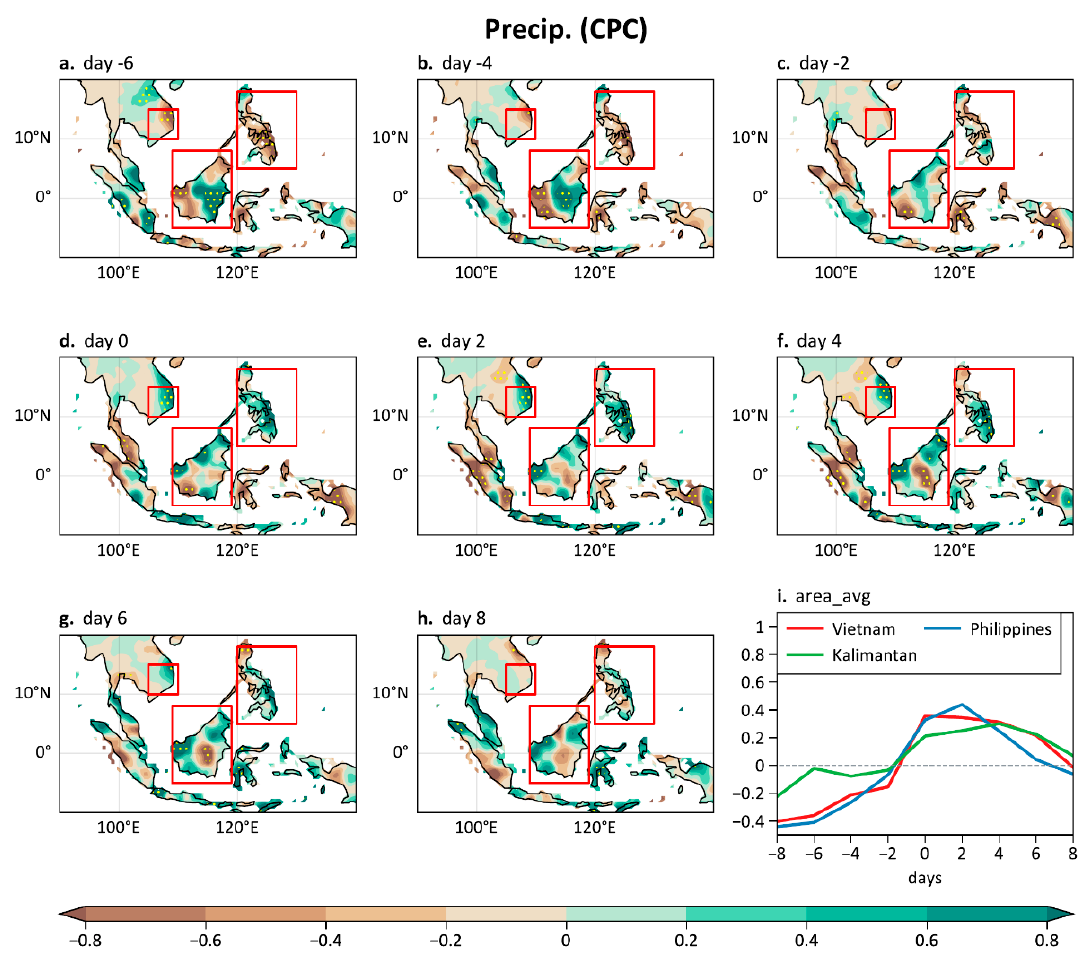
Figure 7. ( a – h ) Composite anomalies of CPC precipitation over land (mm day − 1 ) at days − 6 to 8 with an interval of 2 days during the strong EAWM events. ( i ) Composite of area-mean landmass precipi- tation anomalies for Vietnam (10 ◦ –15 ◦ N, 105 ◦ –110 ◦ E), Kalimantan Island (5 ◦ S–8 ◦ N, 109 ◦ –119 ◦ E), and the Philippines (5 ◦ –18 ◦ N, 120 ◦ –130 ◦ E). Stripping regions in ( a – h ) indicate the precipitation anomalies exceed the 95% confidence level.